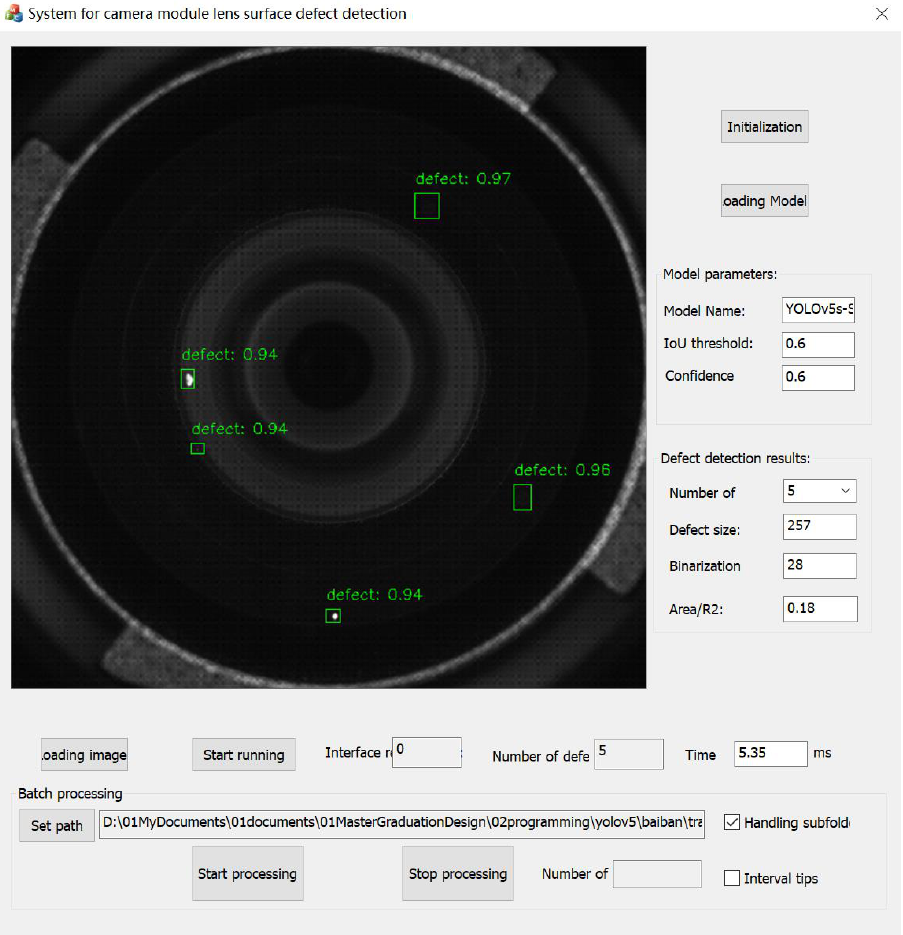
Figure 23. Example diagram of the software runtime interface under GPU RTX 3070 configuration.